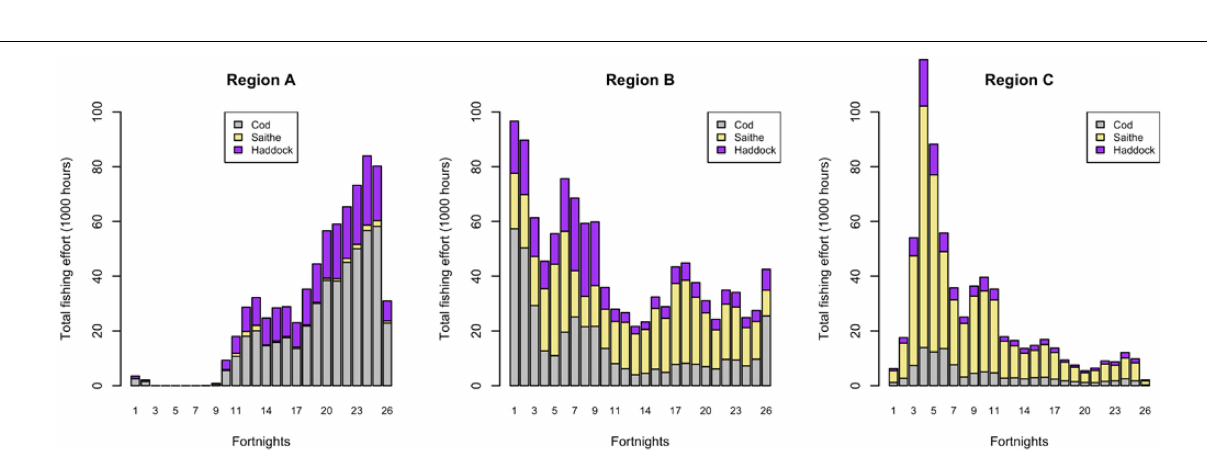
FIGURE 3 | Average of the total effort allocation in the codfish in the trawl fleet, consist of 53 licensed vessels on fortnightly basis in regions A, B, and C over the period of 2011–2016. The effort is measured trawling hours. The Norwegian Directorate of Fisheries (Norwegian: Fiskeridirektoratet).